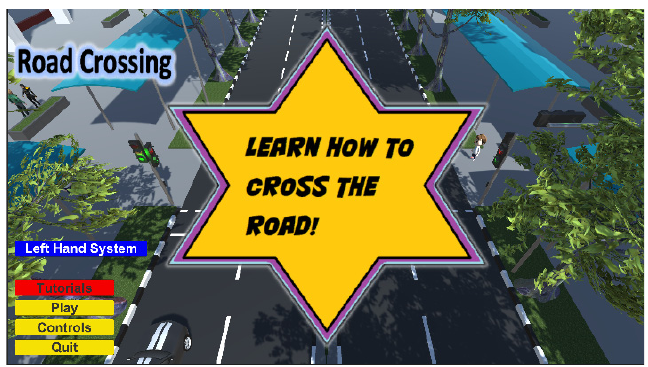
Figure 7. Main menu of the serious game with left-hand driving system.